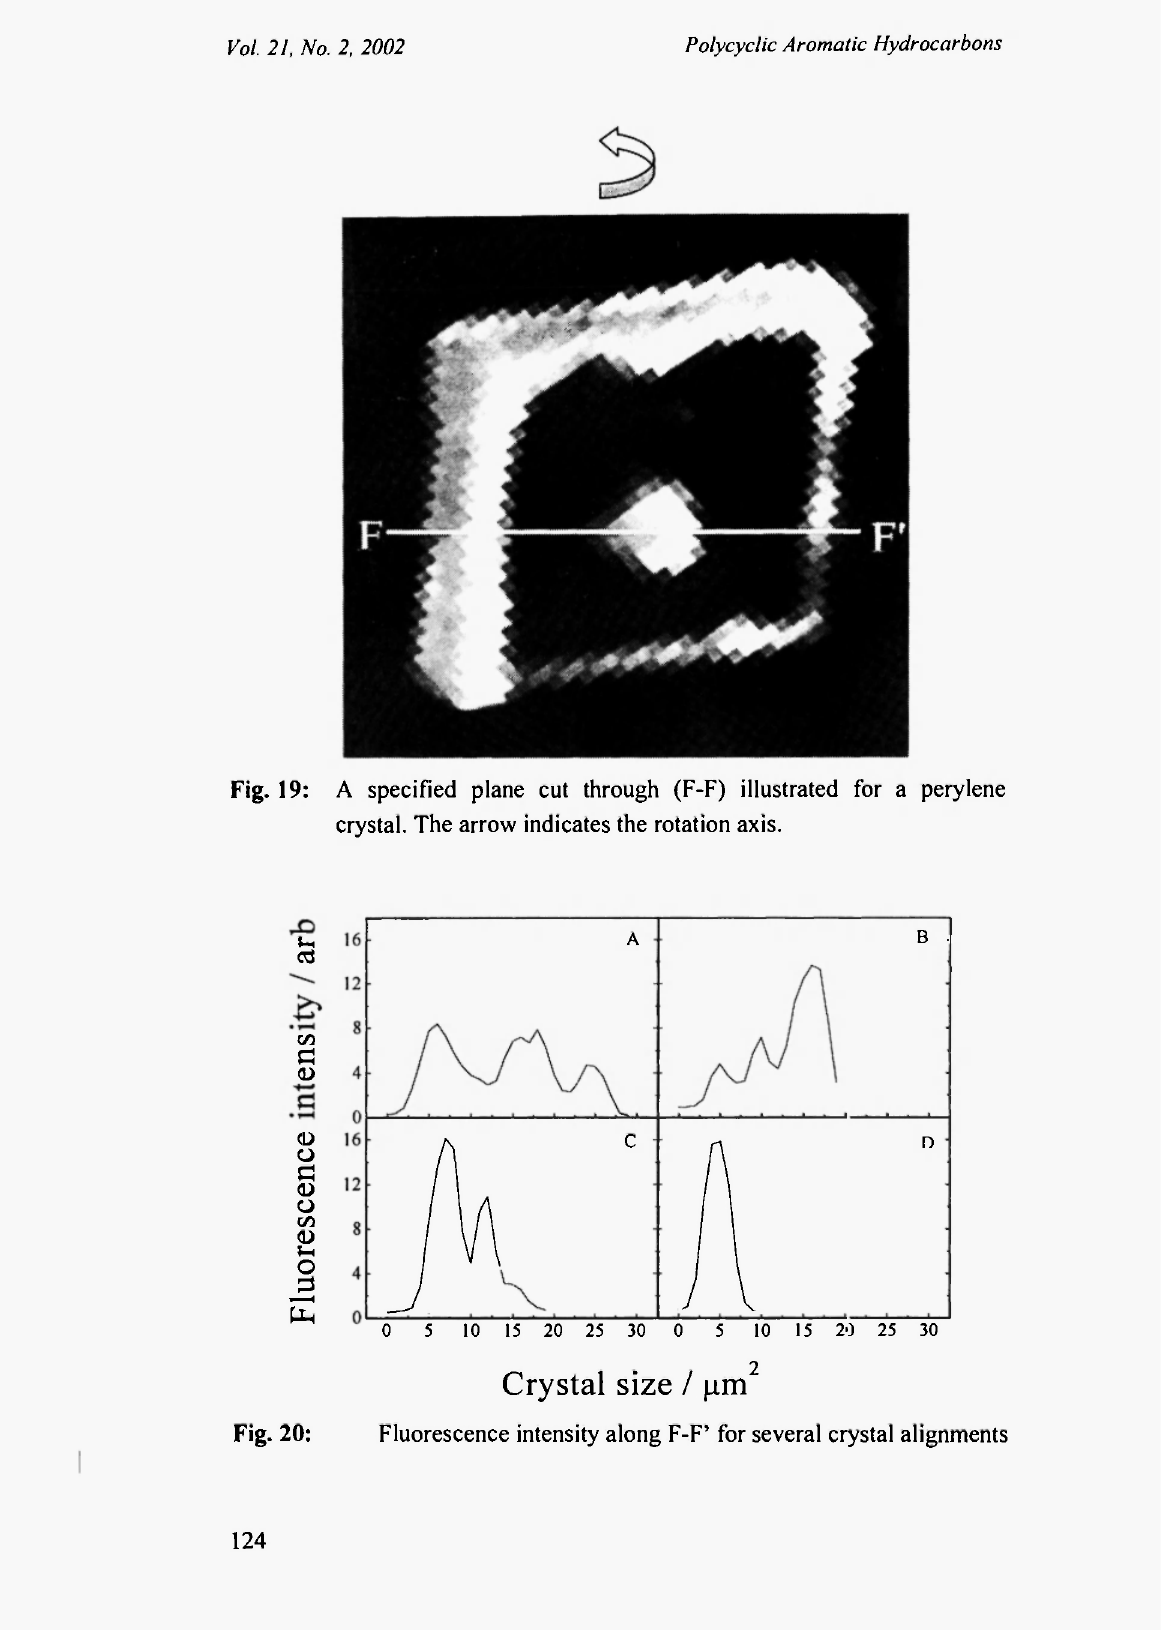
Fig. 20: Fluorescence intensity along F-F' for several crystal